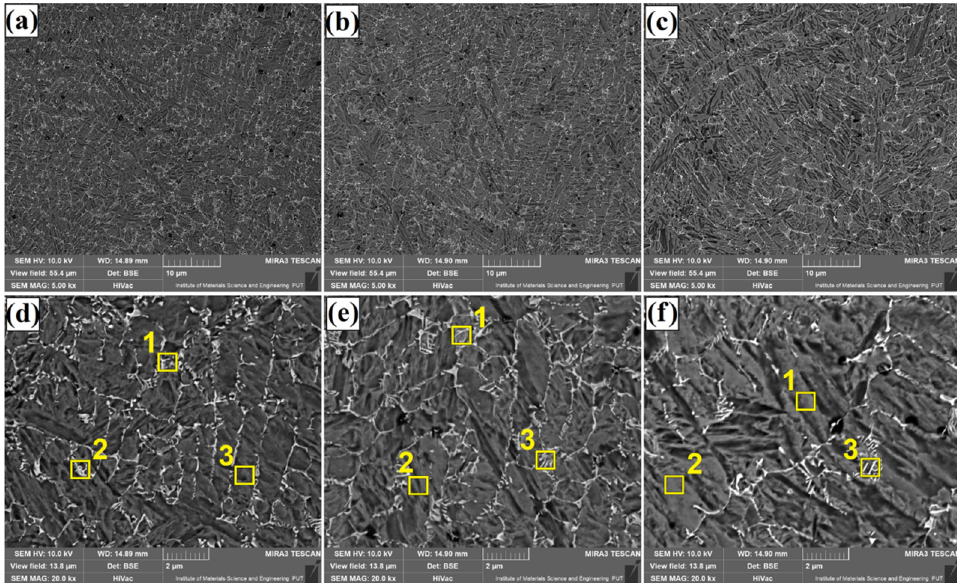
Figure 8. Middle area of the Fe/TaC coatings produced on tool steel using 60 µm thick pre-coat and laser beam power of 500 W ( a , d ), 800 W ( b , e ), 1100 W ( c , f ).